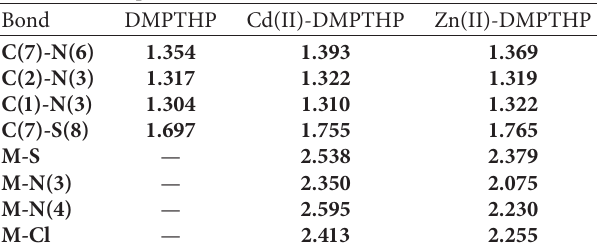
Figure 2: The molecular structure of the (Zn(DMPTHP)Cl) complex along with the atom numbering scheme. Table 2: Selected bond length of the DMPTHP ligand and M(II)- DMPTHP complexes.